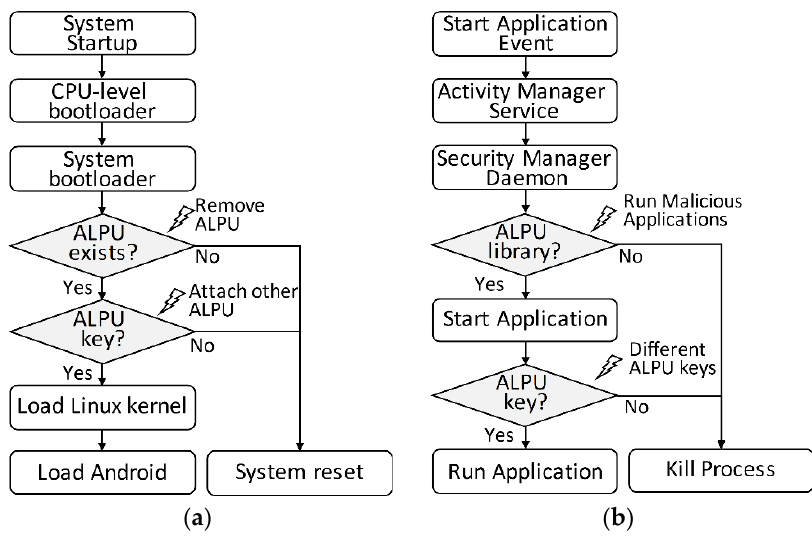
Figure 4. Flow diagram and adversary model of the policy oriented security scheme: ( a ) Booting process; ( b ) Android application layer.